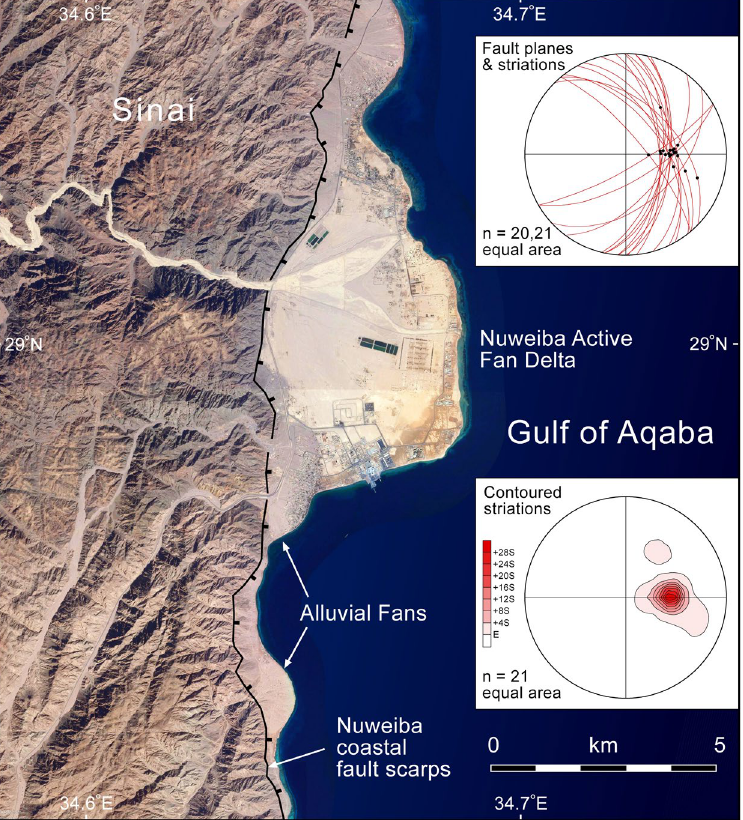
Figure 6. Outcrop measurements of the Nuweiba coastal fault system on the Sinai coastline. 20 stations were recorded; at one location two different sets of striations were observed. All faults cut partially lithified conglomerate and sandstone deposited in active alluvial fans. The average slip direction plunges 56° toward 090° (east-west extension). No strike-slip faults were observed; a few had minor oblique-slip component. Location of map is shown in Fig. 3. Basemap data: Google, SIO, NOAA, US Navy, NGA, GEBCO; Image